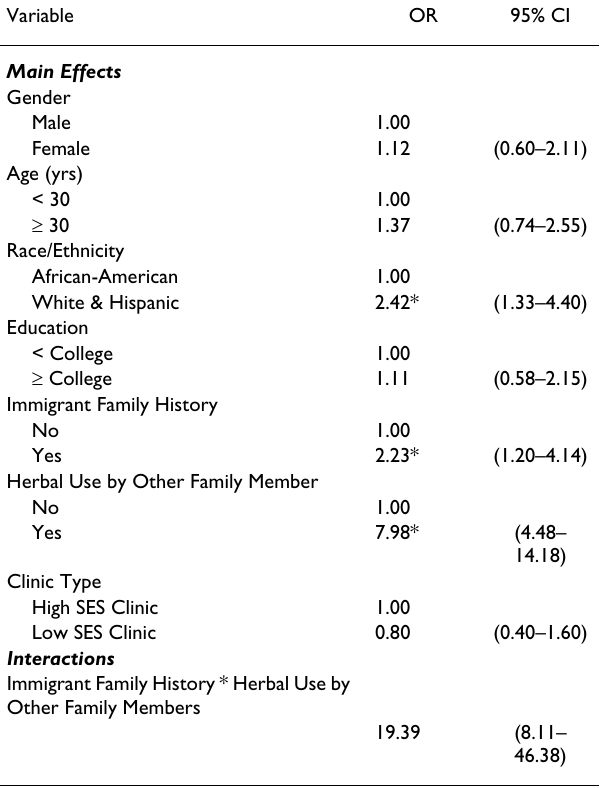
Table 4: Multiple Logistic Regression Analysis of Factors Associated with Herbal Use Among Urban Multiethnic Primary Care Patients (n = 302)